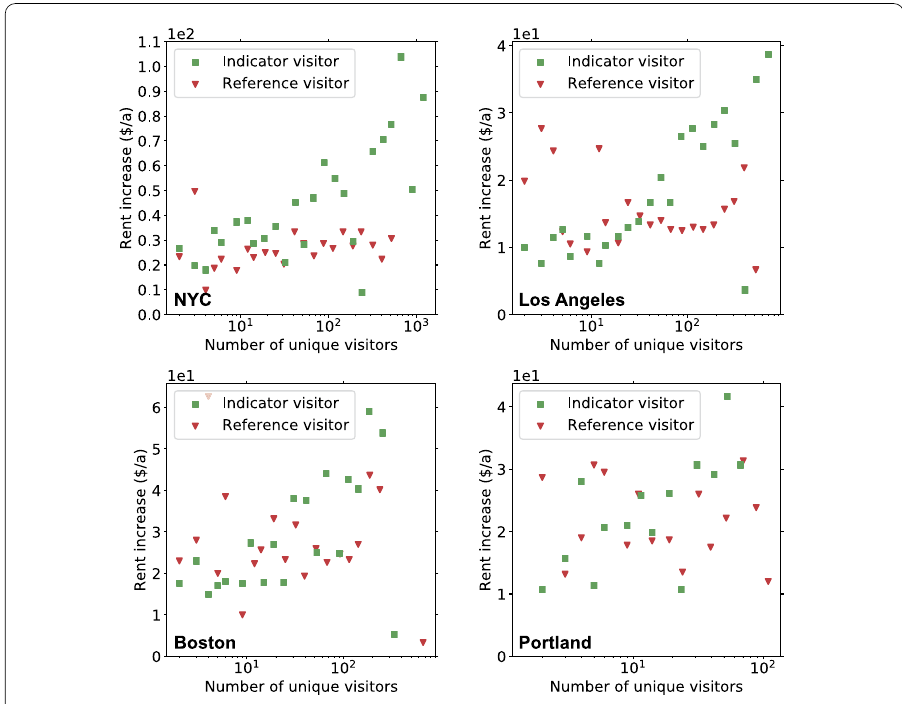
Figure 4 Robustness of the indicator group across multiple cities. Comparing the rent price predictions of the indicator group and the reference group for New York City (indicator group: r s = 0.70; p < 10 –4 ; N = 25, reference group: r s = 0.46; p = 0.03; N = 22), Los Angeles (indicator group: r s = 0.73; p < 10 –4 ; N = 23), Boston (indicator group: r s = 0.57; p < 10 –2 ; N = 20) and Portland (indicator group: r s = 0.67; p < 10 –2 ; N = 14). The correlation values for the reference group in Los Angeles, Boston and Portland are not significant ( p >